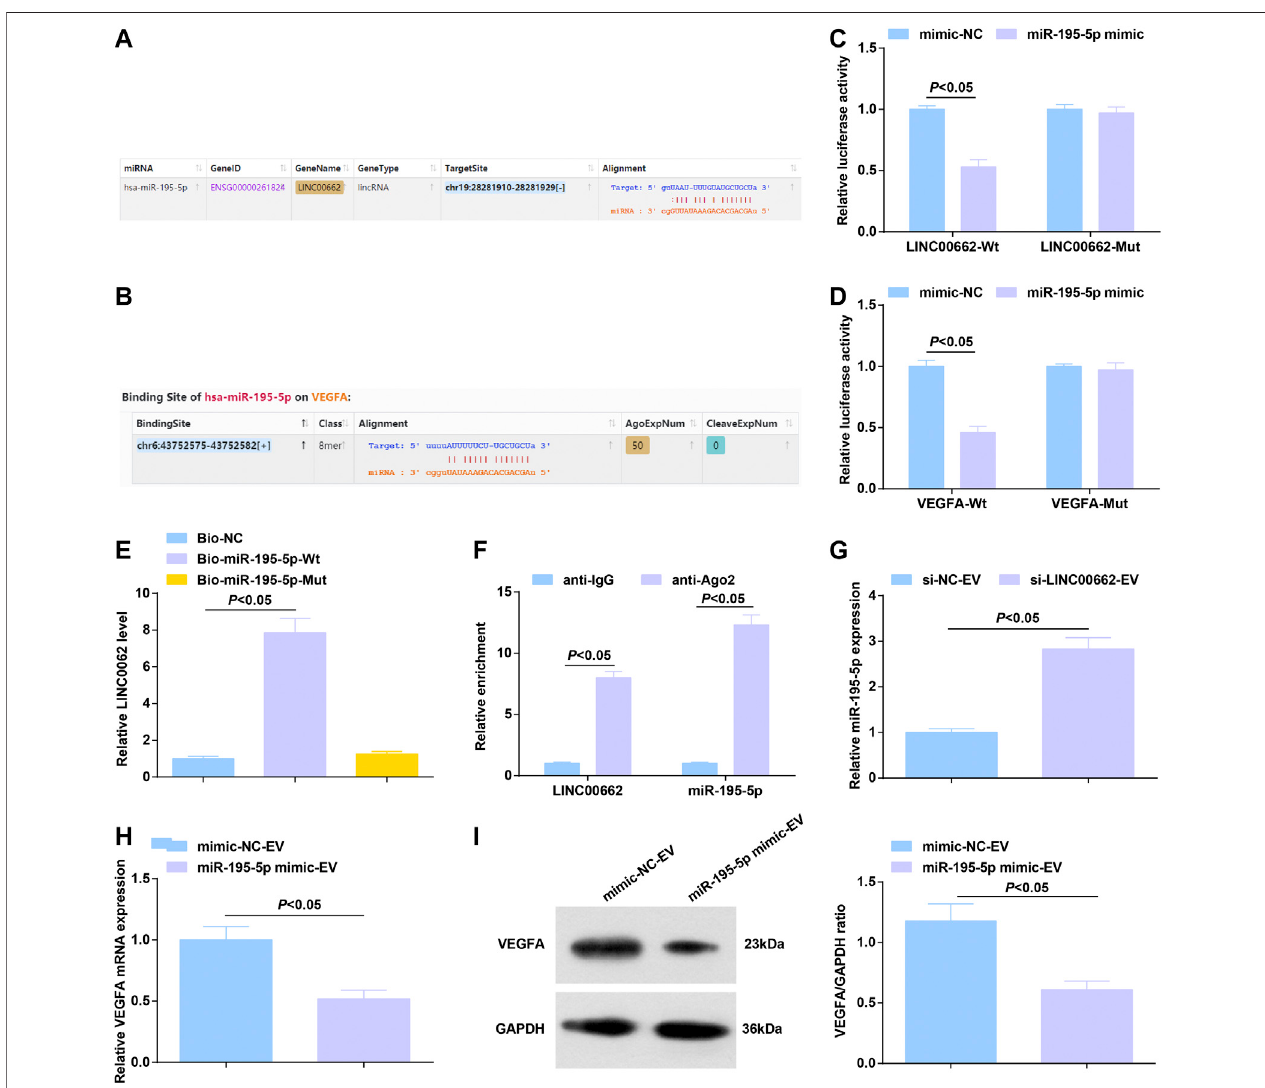
FIGURE 6 | Binding relation between LINC00662 and miR-195-5p; targeting relation between miR-195-5p and VEGFA. (A,B) Binding sites of LINC00662 and miR-195-5p,miR-195-5pandVEGFA; (C,D) Dualluciferase reportresults; (E) RNApull-down test detected theenrichmentofLINC00662; (F) RIPdetectedthebinding of LINC00662 and miR-195-5p to AGO2; (G) RT-qPCR detection of miR-195 – 5p expression in HUVECs after co-culture with EVs; (H,I) RT-qPCR and Western blot analysis of VEGFA mRNA and protein expression in HUVECs after co-culture with